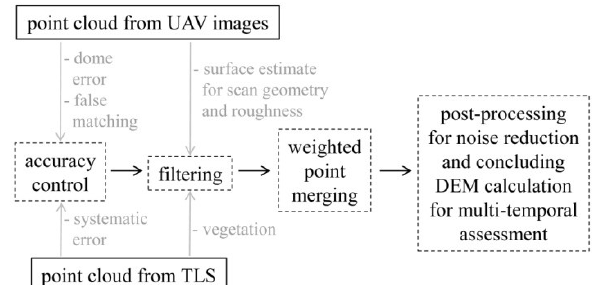
Figure 3. Conceptual workflow for synergetic fusion of data acquired from TLS and UAV photogrammetry (after Eltner, 2016). UAV DEMs are further exploited to filter the TLS data in regard of scan geometry. Thus, the UAV DEMs are